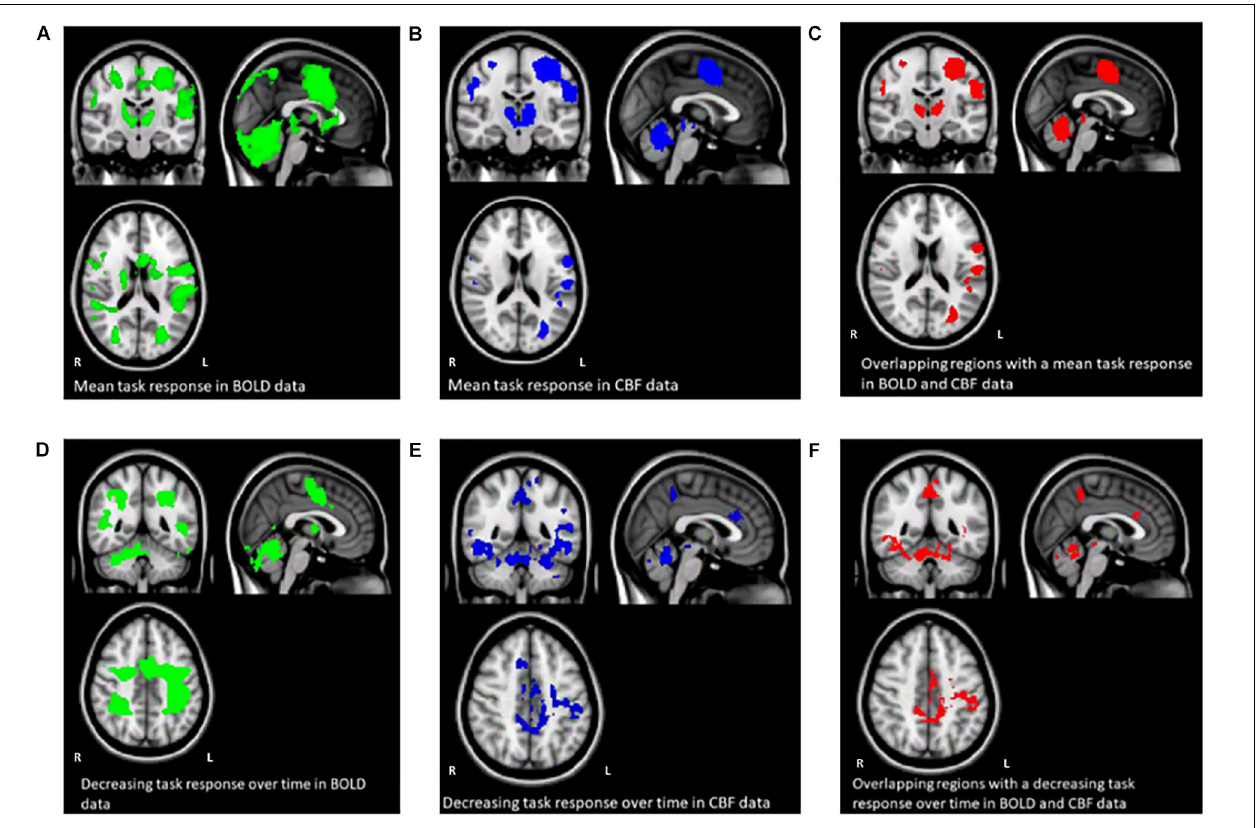
FIGURE 3 | Maps (A–C) show the mean BOLD signal response to the task across all subjects and sequence blocks (green), the CBF response (blue), and regions with overlapping BOLD and CBF task-related signal increases from rest (red). Maps (D–F) show areas of BOLD signal decrease over time during the SRT task (green), decreasing CBF responses (blue) and overlapping BOLD and CBF signal decreases across the task. Random blocks were not included in this